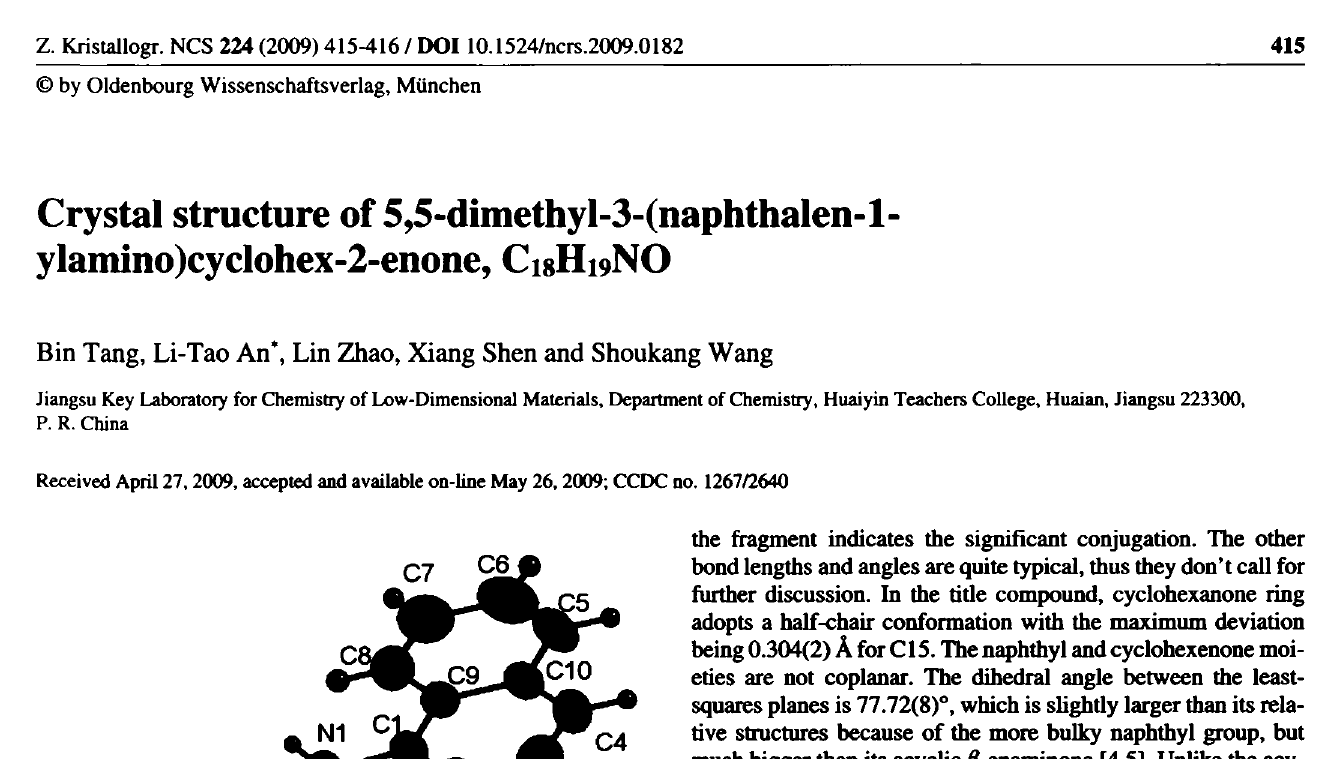
Table 1. Data collection and handling.